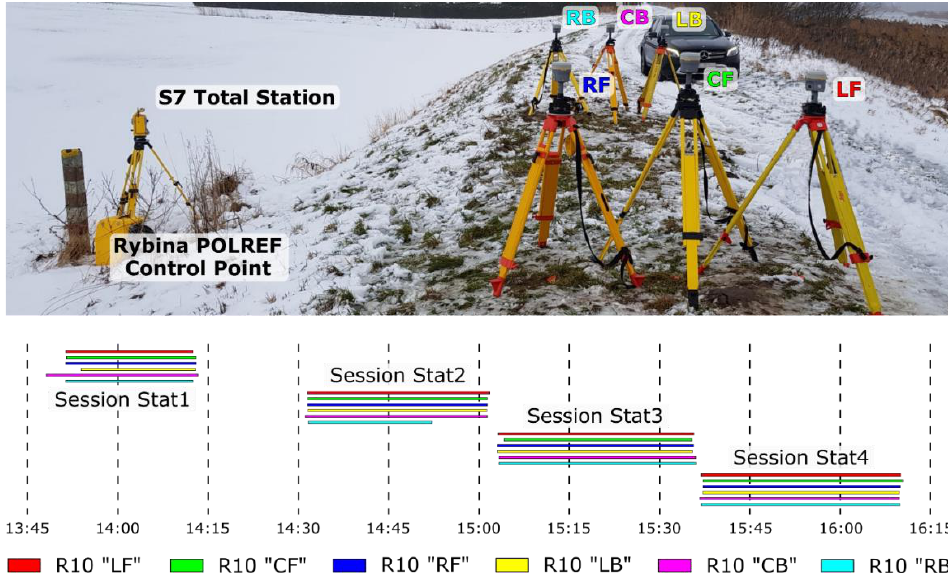
Figure 2. UTC time series of the GNSS static sessions conducted in Rybina on 20 January 2021 (DOY: 20).